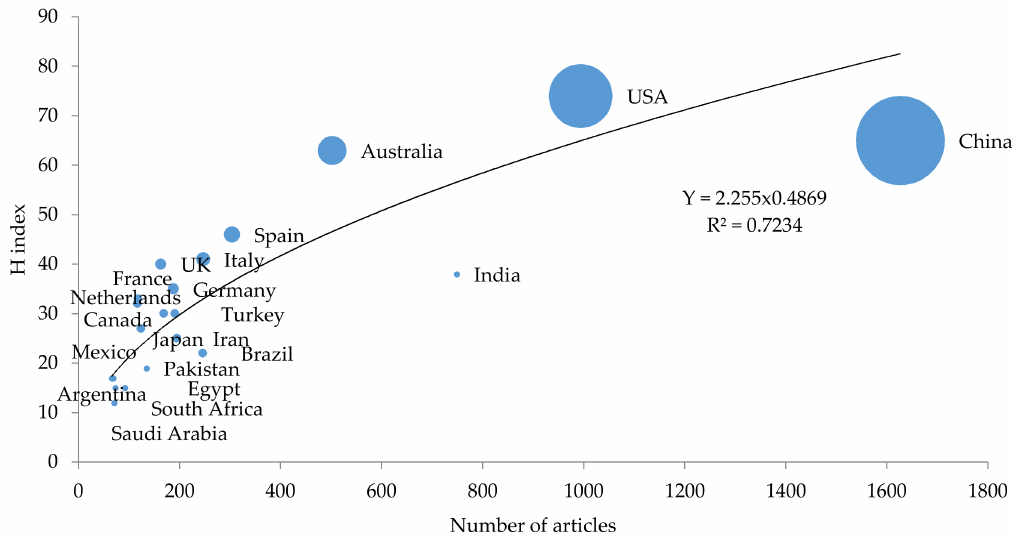
Figure 3. Quantitative relationship between the H Index and total number of articles by country for WUEA research from 1988 to